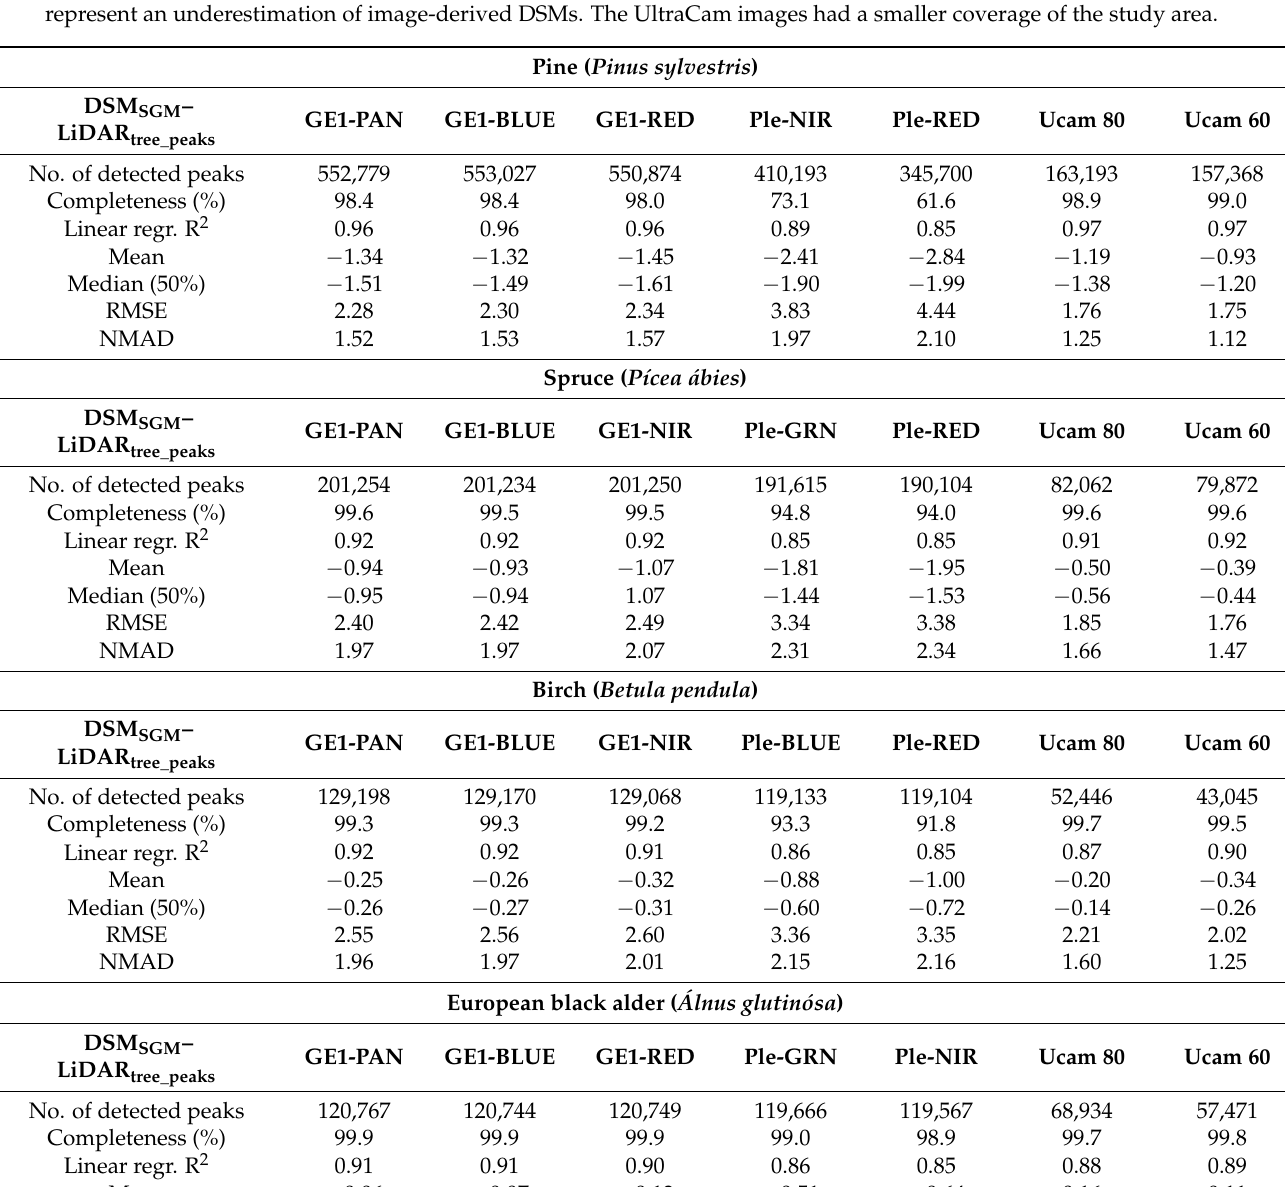
Table 5. Descriptive statistics of vertical accuracy assessments of image-derived DSMs compared to the LiDAR individual canopy peaks and separated by four main vegetation species, where GE1— GeoEye1 , Ple— Pleiades1B , Ucam —UltraCam-based models, PAN—panchromatic and NIR—near-infrared, etc. Values are in metres, except completeness (%). Negative values represent an underestimation of image-derived DSMs. The UltraCam images had a smaller coverage of the study